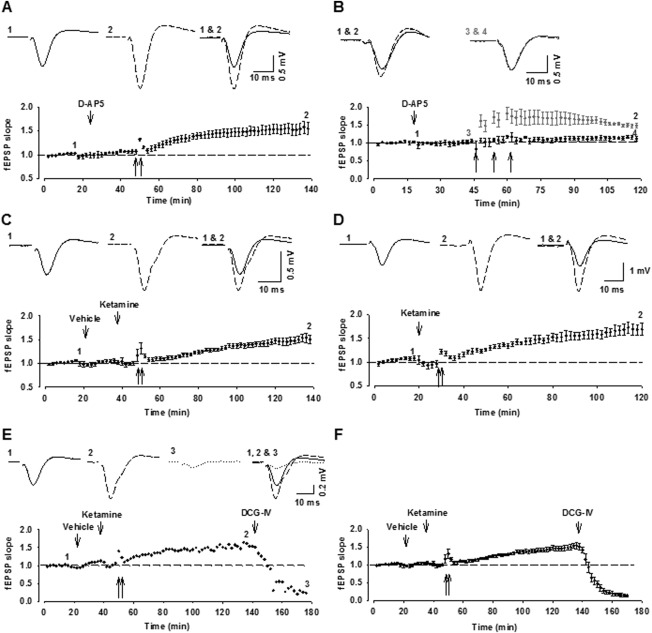
The properties of MF-LTP in vivo. (A) MF-LTP can be induced in the presence of the NMDAR antagonist, D-AP5 (1 nmol, i.h.; n = 4). (B) CA1 LTP can be induced by three trains of tetanization (3 × 100 stimuli at 100 Hz, 240 s intertrain interval; n = 4). The application of D-AP5 (1 nmol, i.h.) 30 min before tetani blocks CA1 LTP (n = 4, darker symbol). (C) MF-LTP recorded in the presence of ketamine (10 mg/kg, i.v., 10 min before tetani). (D) Slow-onset MF-LTP is also induced with urethane anesthesia (n = 4). (E, F) A single example (E) and pooled data (F) (n = 11) showing the effects of DCG-IV (0.01 nmol, i.h.), tested 90 min after the induction of MF-LTP. Unless otherwise stated, in this and subsequent figures, gray symbols represent vehicle controls, and black symbols represent the drug treatment indicated. In this figure and Figures 3 and 4, traces are the average of 4 consecutive fEPSPs responses obtained during baseline (1) and 90 min following (2) the delivery of two tetani (arrows).